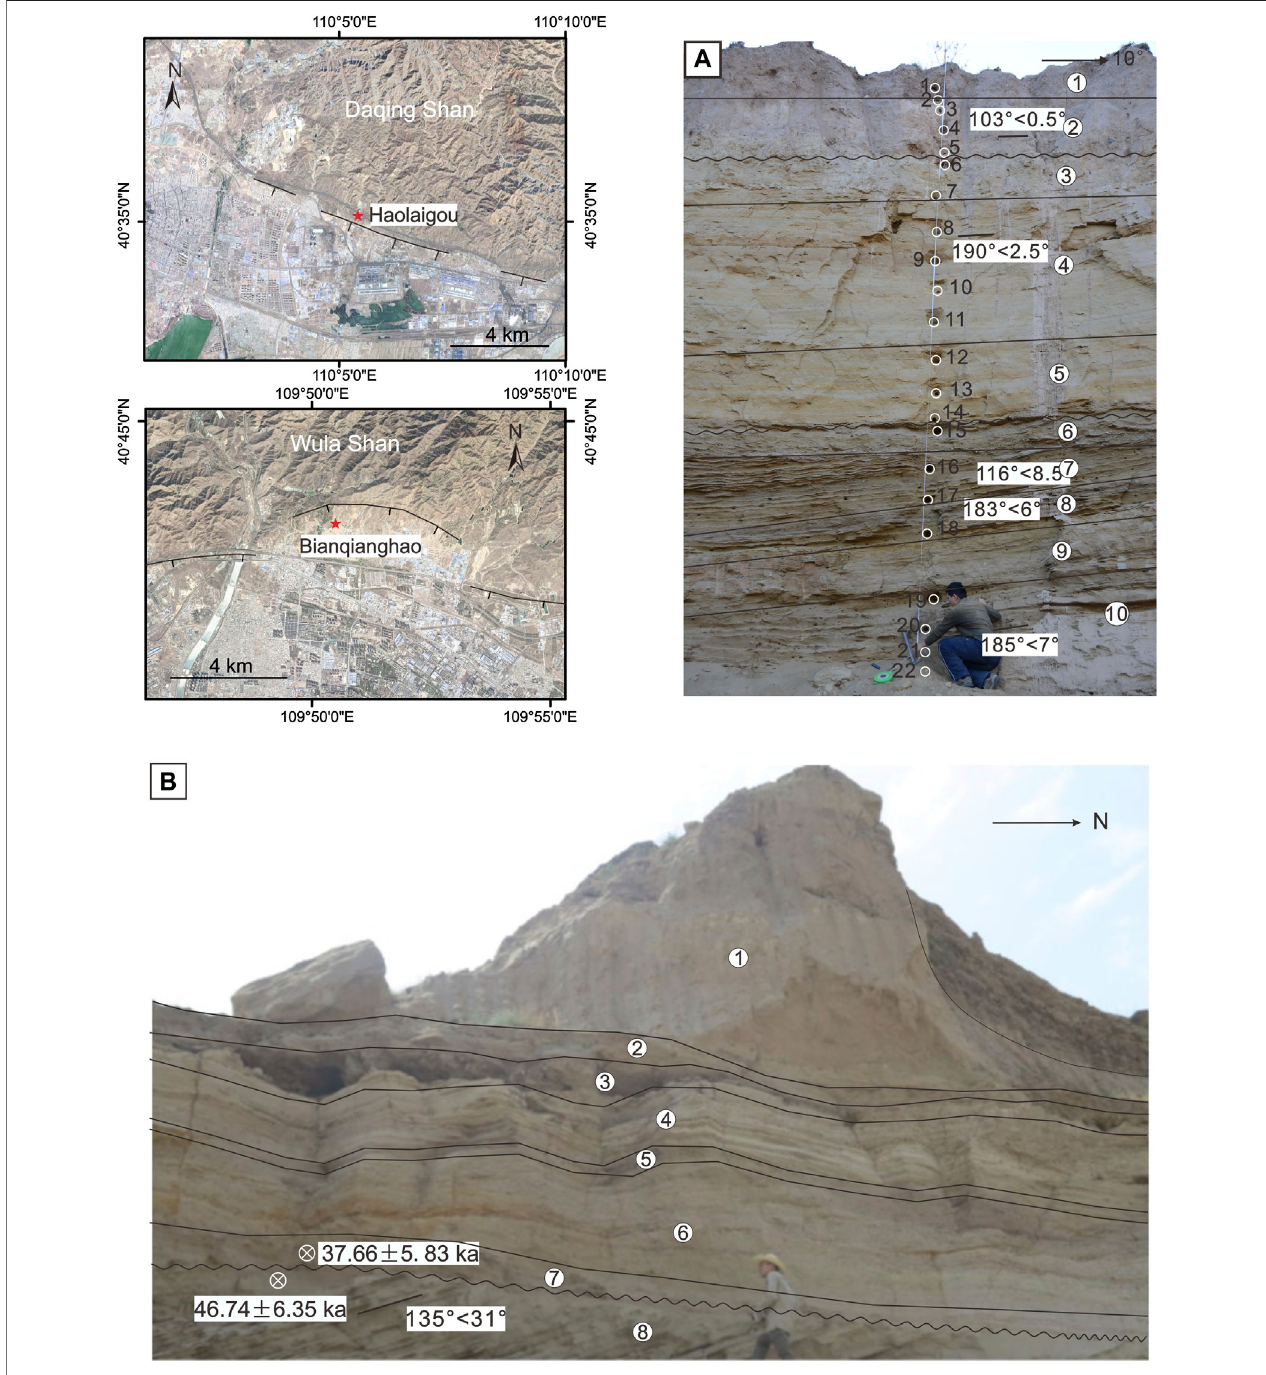
FIGURE 3 | Photos showing four sedimentary sections at Haolaigou (P1), Bianqianghao (P2), Huhusala (P3), and Hazigai (P4).